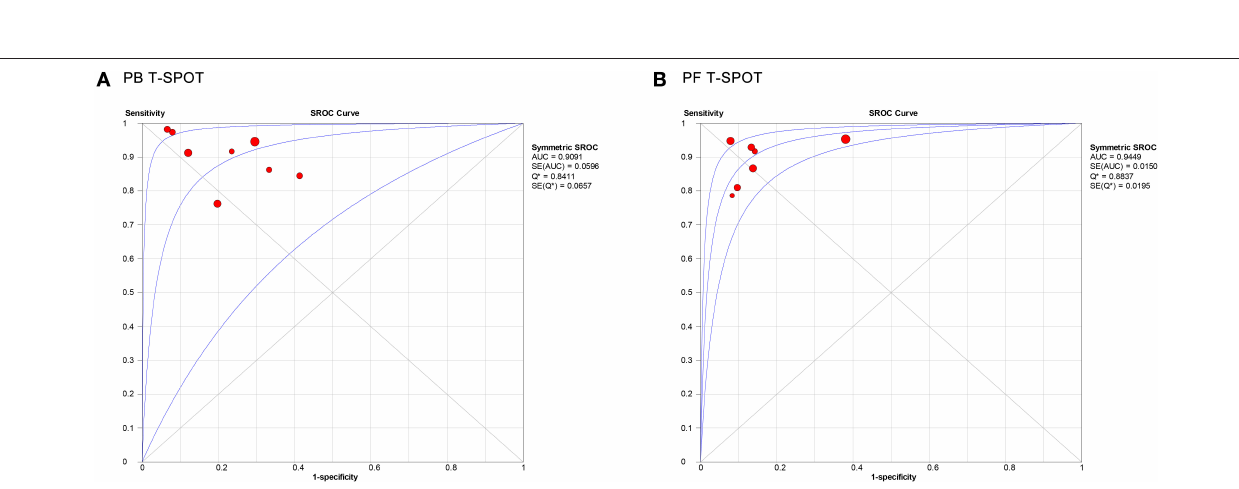
FIGURE 5 | Summary receiver operating characteristic curves for PB T-SPOT (A) and PF T-SPOT (B) for diagnosing TP. PB, peripheral blood; PF, peritoneal fluid; TP, tuberculous